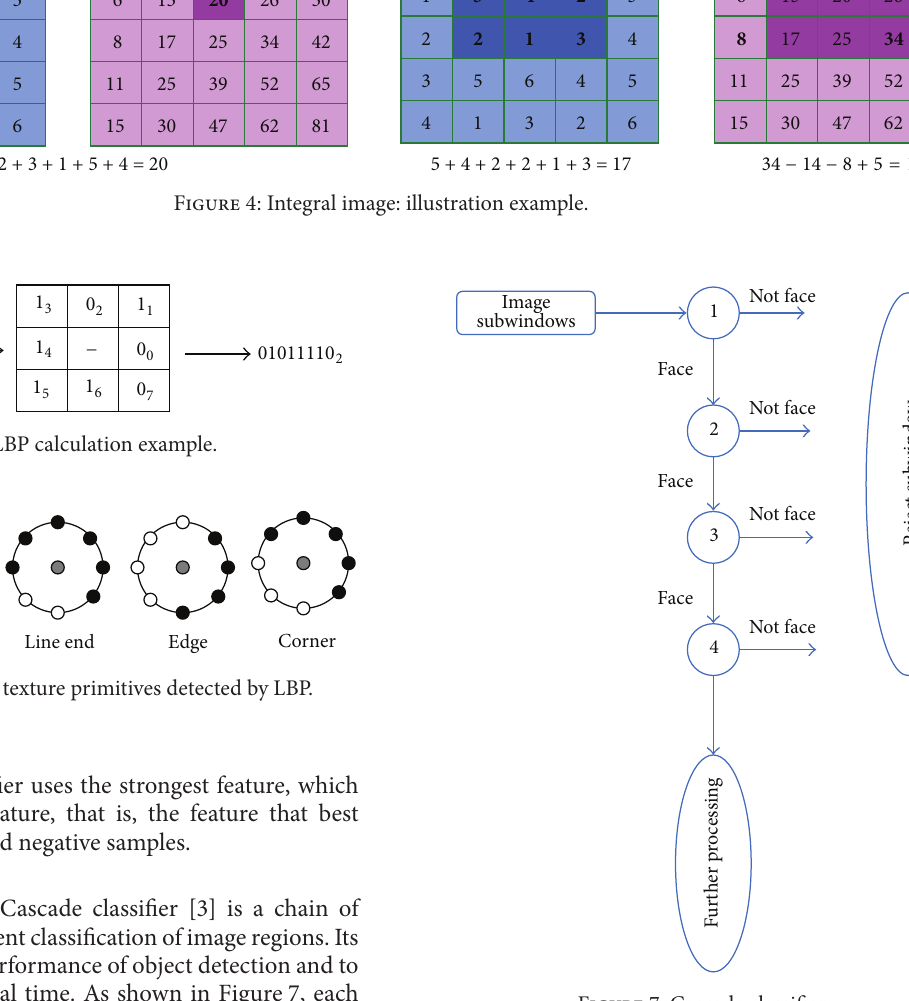
Figure 7: Cascade